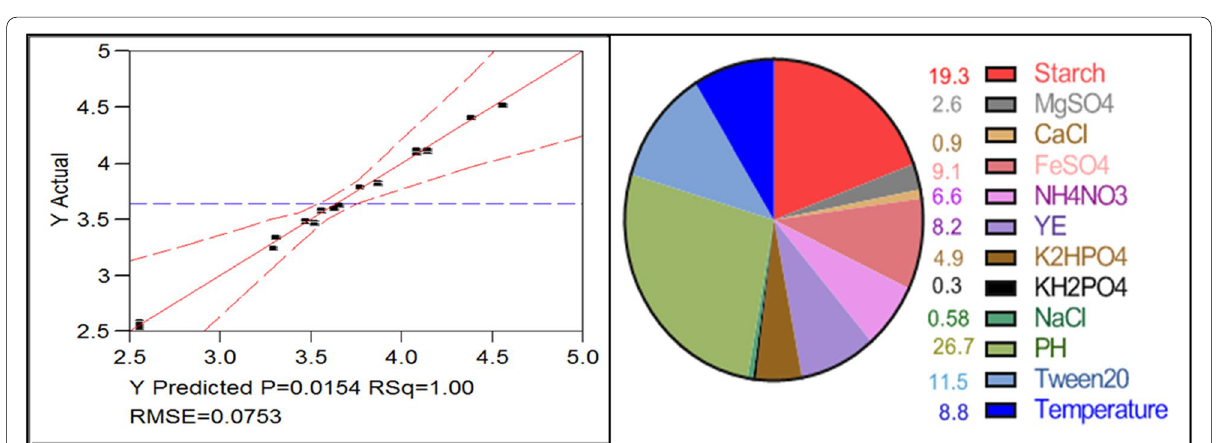
Fig. 3 Actual by predicted correlation plot in PB experiment (left) and a Pareto diagram for PB analysis, downsize the effect of each variable (%) on CHO production